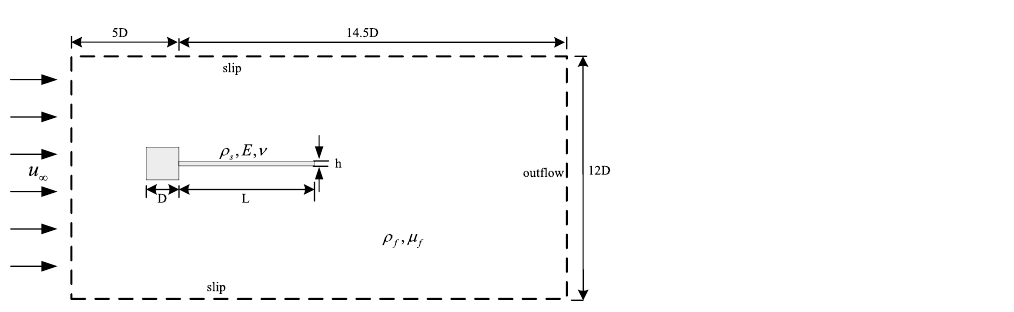
Figure 4. Flutter boundary for AGARD 445.6 wing.